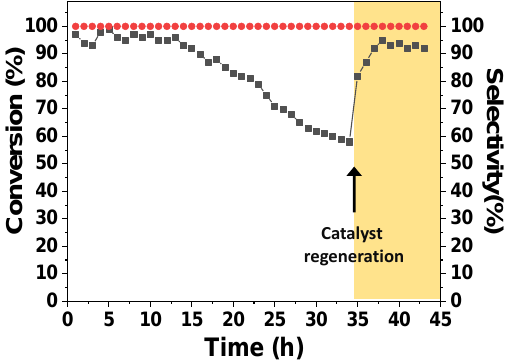
Figure 6. Continuous-flow catalytic reaction using CuO@SiO 2 -MN. Reaction conditions: T = 60 °C, air, styrene oxide 0.035 M, flow rate 0.1 mL/min: (black squares) conversion, (red circles) selectivity for β-alkoxy alcohol.